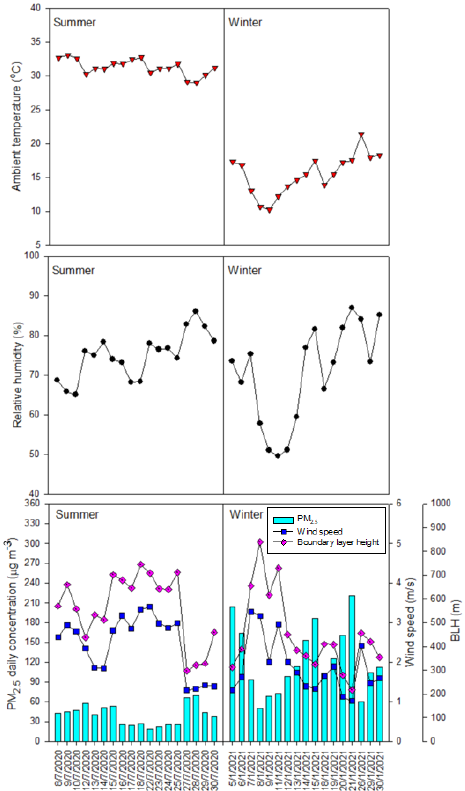
Figure 2. PM 2.5 daily mean concentration and meteorological conditions for the summer and winter periods. Table 1. Statistical summary of daily PM 2.5 measurement and meteorological conditions.